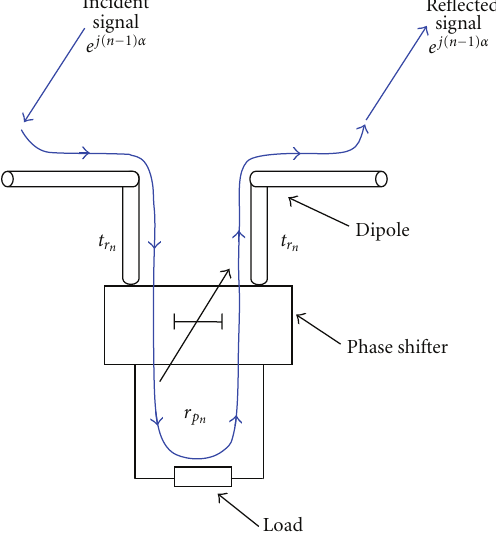
Figure 6: Signal reflection at the phase